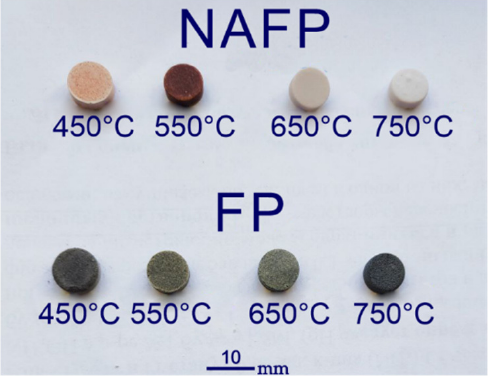
Figure 1. Appearance of the obtained samples of FP and NAFP matrices.